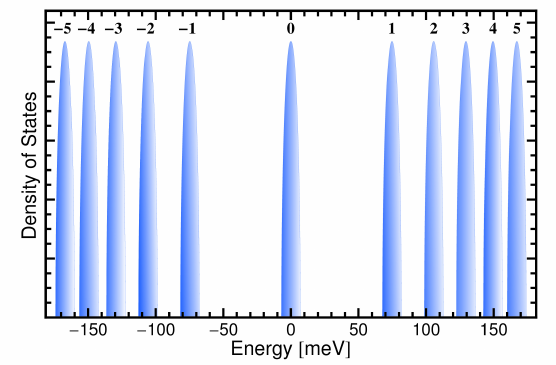
Figure 6: Density of states. DOS of the energetically lowest Landau levels as obtained in a self-consistent Born approximation for an impurity scattering parameter A imp = 200 at a magnetic field of B = 4T . The Figure is taken from Ref. [73] Copyright (2014) by Nature Publishing